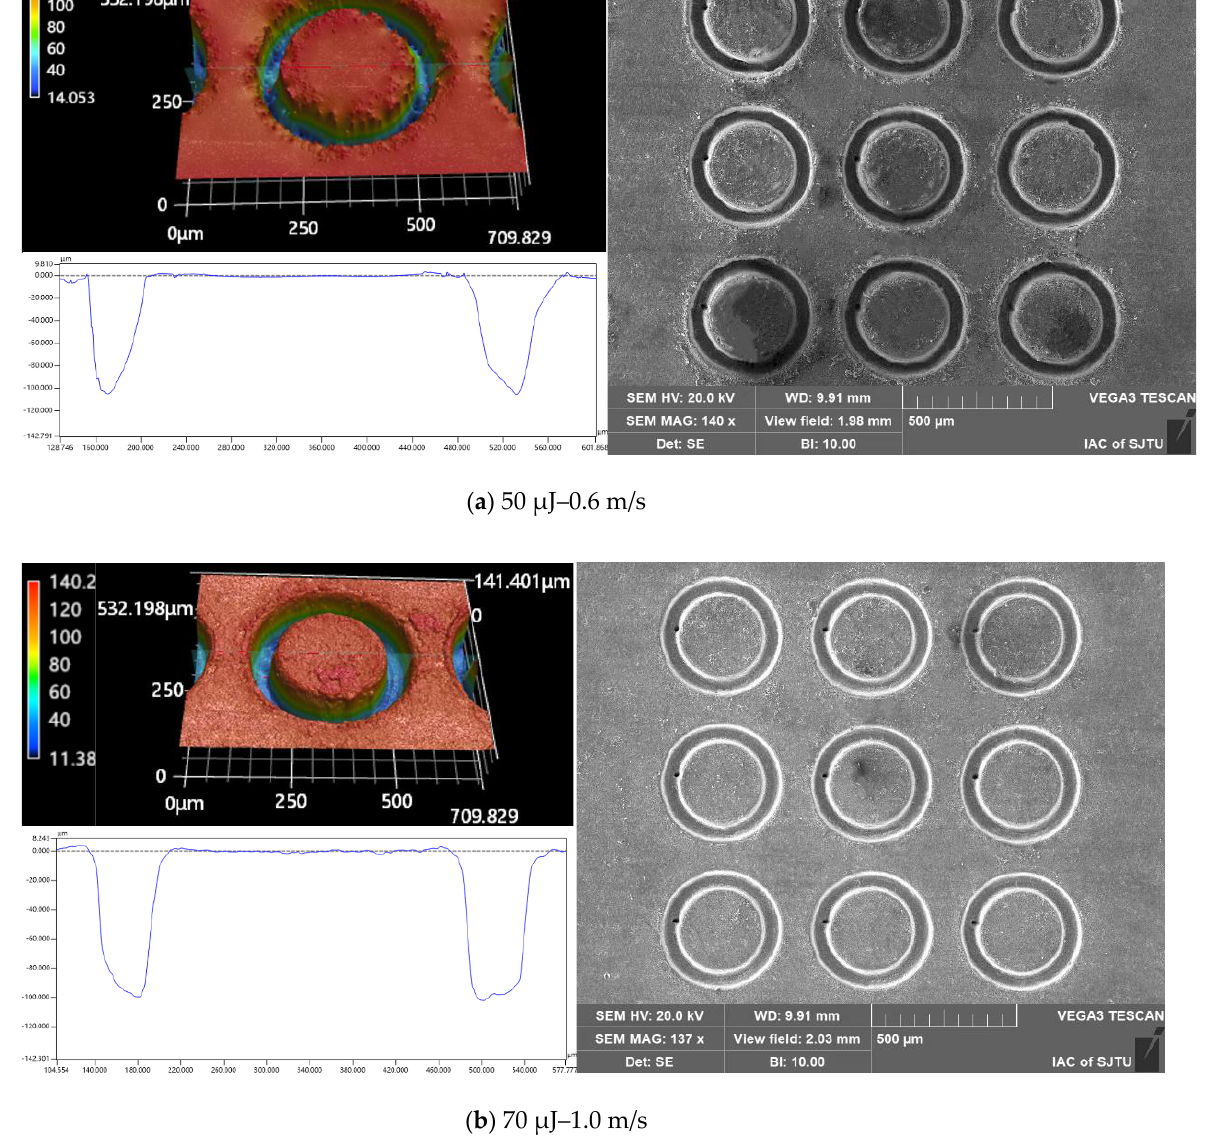
Figure 15. The cross-section profile and SEM image of the micropillars fabricated at the same height of 102 μm with different laser machining parameters: ( a ) 50 μJ– 0.6 m/s; ( b ) 70 μJ– 1.0 m/s.